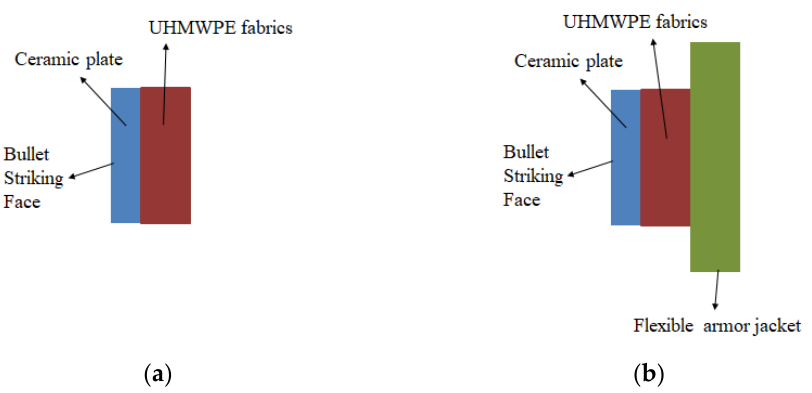
Figure 3. The illustration of the armor or armor system prepared for ( a ) the CA test ( b ) the SA test. The strength of the samples was measured using the three-point bending test. The specimens were cut into 3 × 4 × 35 mm in size. The fracture toughness of the samples